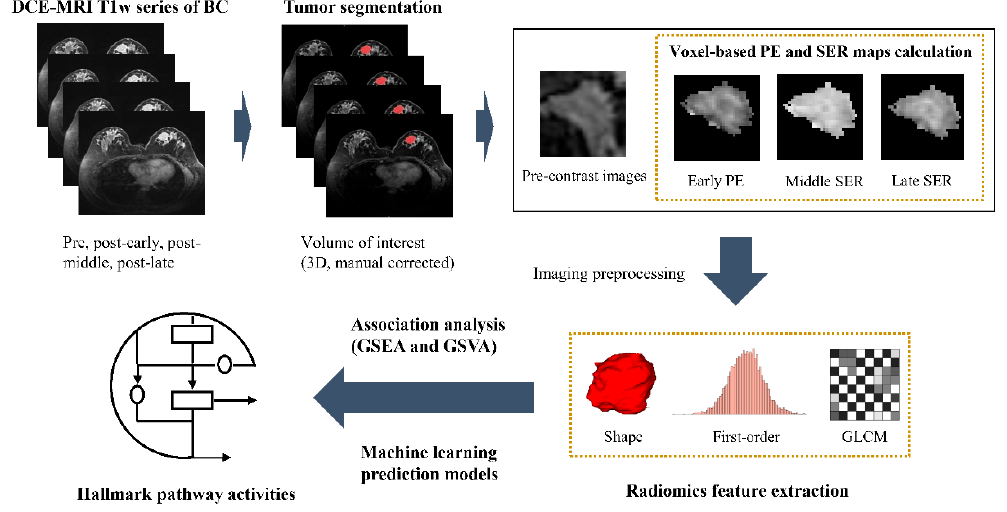
Figure 1. The workflow of this DCE-MRI- and RNA-Seq-data-based radiogenomics study.